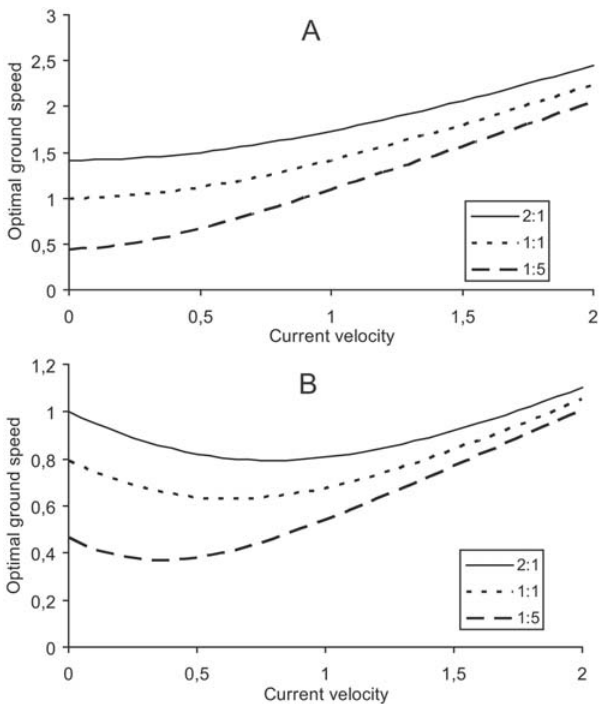
Figure 1. Theoretical predictions of the relationship between current velocity and optimal ground speed for fish swimming against currents. Illustrations are shown for x =2 (A) and x =3 (B) (for equations, see text), and for different a : b ratios (2:1; 1:1 and 1:5).